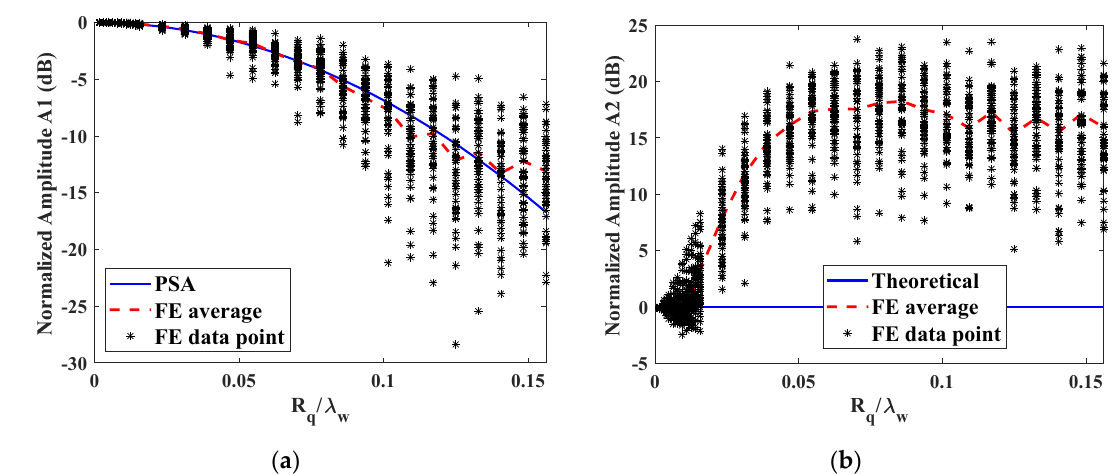
Figure 12. Variation of reflected amplitudes from rough surfaces as a function of normalized roughness R q with respect to the smooth surface: ( a ) fundamental amplitude A1 and ( b ) second harmonic amplitude A2. The roughness is normalized by the incident wavelength λ w . Results shown for FE simulations compared with PSA